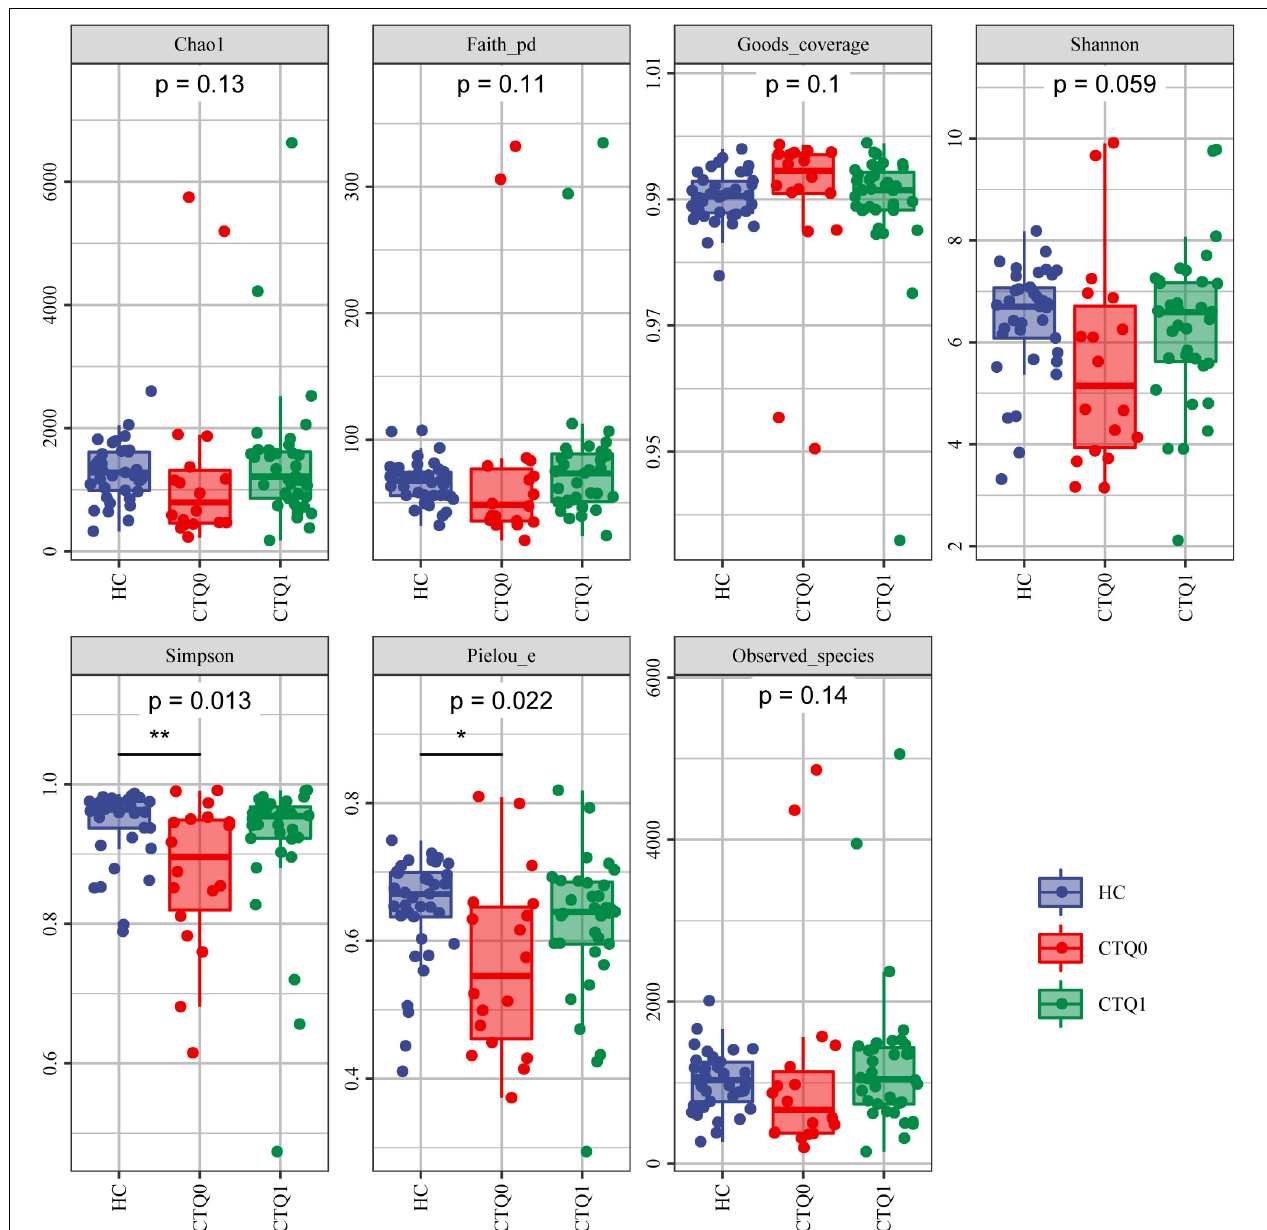
FIGURE 1 | α -diversity of HCs, the CTQ0 group and the CTQ1 groups (marked by blue, red, and green dots and areas, respectively). * P < 0.05, ** P <